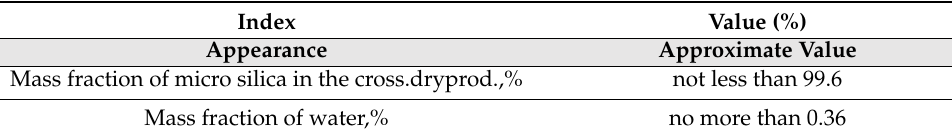
Table 2. Properties and Chemical Composition of Micro silica MK-85.